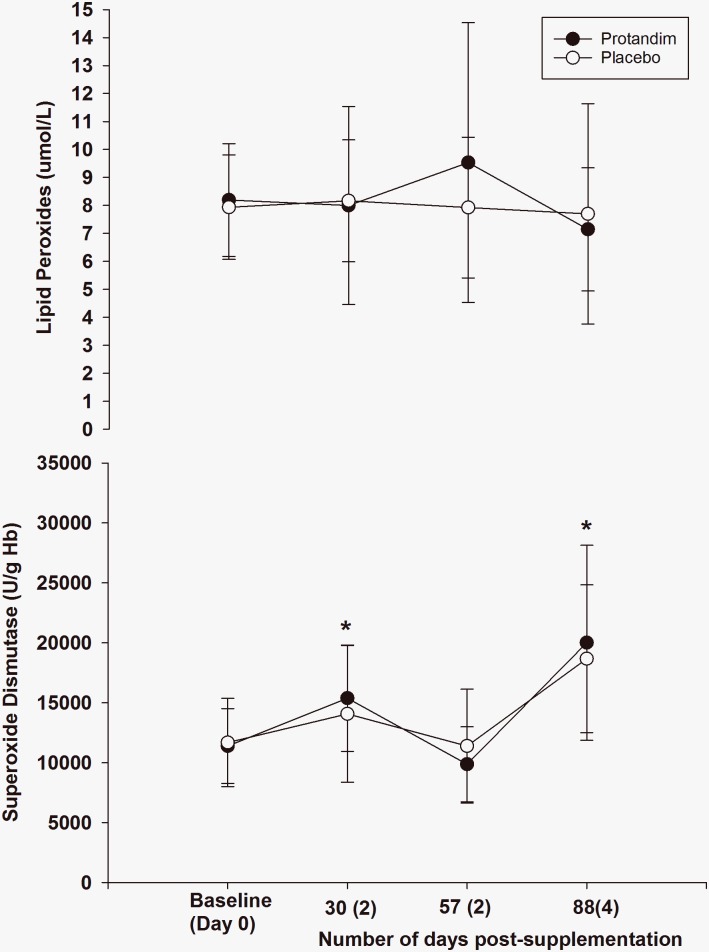
The long term effects of supplementation on lipid peroxides and superoxide dismutase (rest, fasted state).There was no difference between groups for either variable (p = 0.74 for lipid peroxides, and p = 0.81 for superoxide dismutase). The asterisk* signifies statistical significance for superoxide dismutase at 30 days post-supplementation (p = 0.00) and 88 days post-supplementation (p = 0.00) compared to the baseline value, after adjustments for multiple comparisons. Mean values represented by circles, error bars represent SD. The x-axis represents the mean (SD) of the number of days post-supplementation.